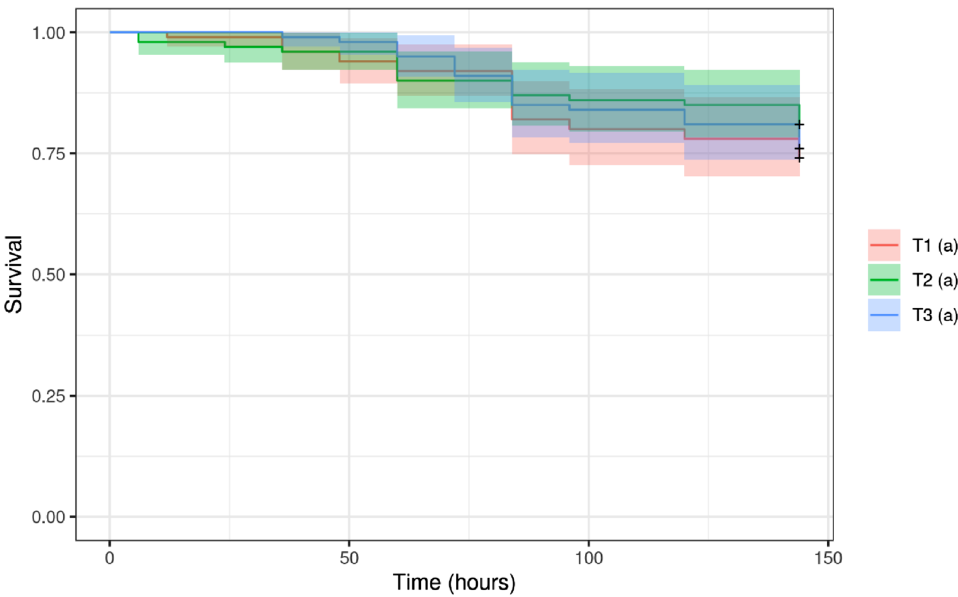
Figure 1. Graph of the survival of newly emerged (24-h-old) worker bee of Africanized Apis mellifera , by Kaplan–Meier, adjusted to the period (h) after feeding with Candi paste incorporating commercial products (T2, Dipel; T3, Xentari) or the control diet (T1). The bees were kept in controlled environment (26 °C ± 2 °C, RH, 60% ± 10%; 12-h photoperiod). The same letters indicate that there was no significant difference between the results ( p <